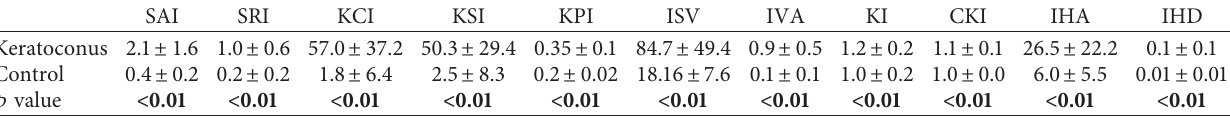
Data are given as mean ± SD. SAI, surface asymmetry index; SRI, surface regularity index; KCI, Klyce/Maeda keratoconus index; KSI, Smolek/Klyce neural network index; KPI, keratoconus prediction index; ISV, index of surface variance; IVA, index of vertical asymmetry; KI, keratoconus index; CKI, central keratoconus index; IHA, index of height asymmetry; IHD, index of height decentration. A significant difference was found in all factors between both groups ( p < 0 . IHA, IHD, CCT, PCP, and PCA between both groups ( p < 0 . 001).